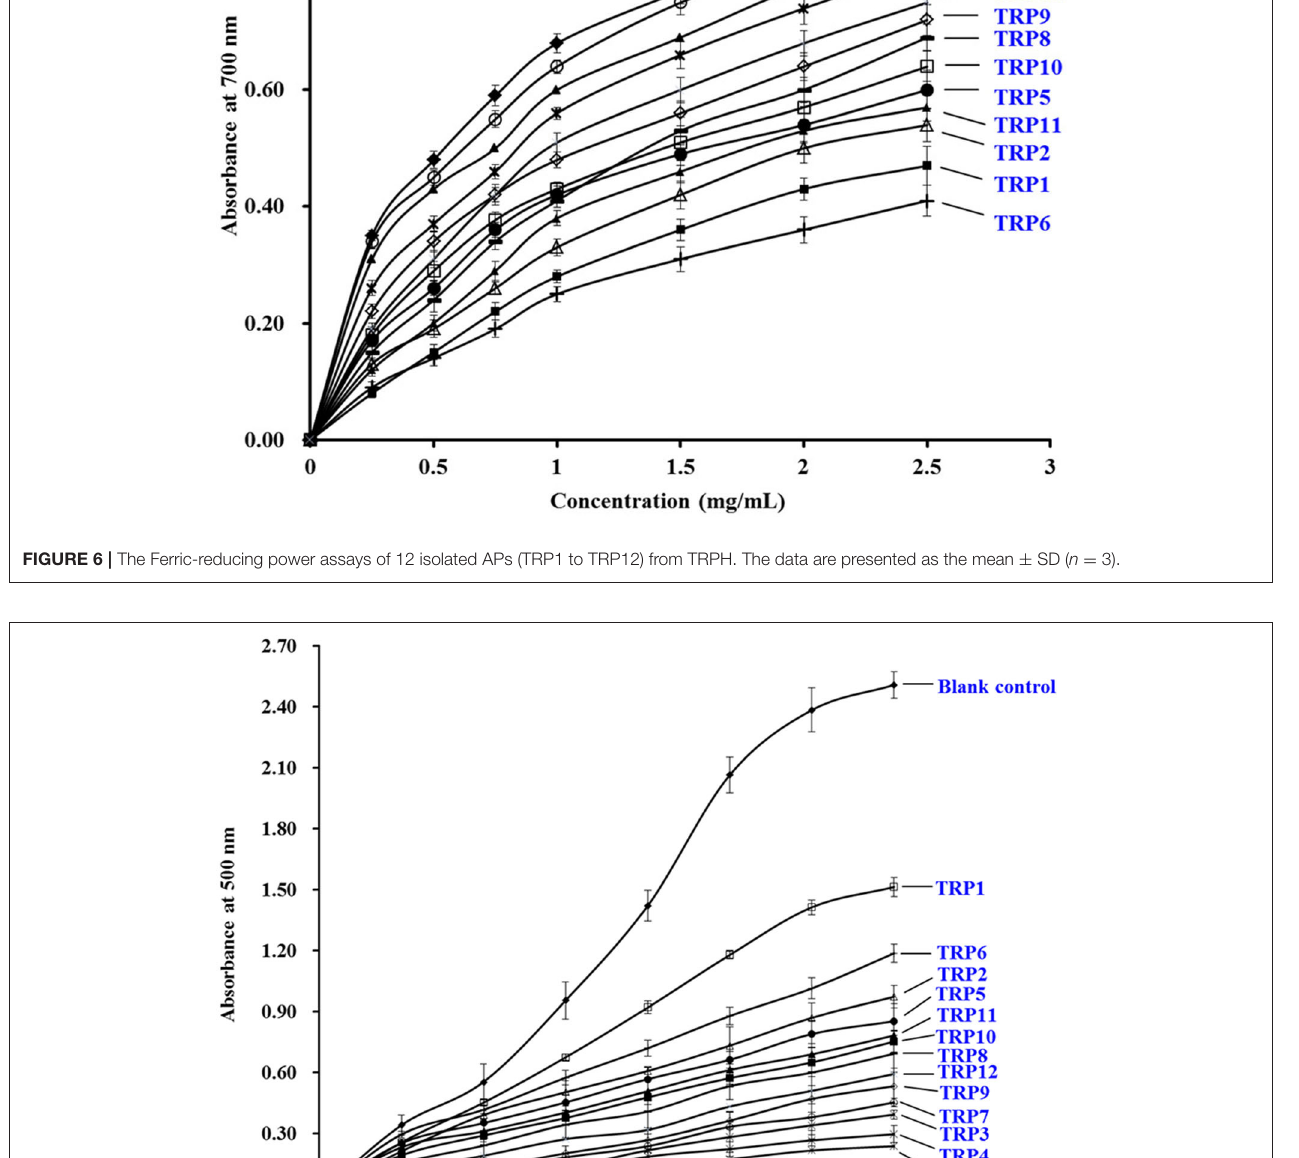
that TRP6 could promote the proliferation of Chang live cells. In addition, the cell viability of other 10 peptides groups ranged from 95.93 ± 2.48% (TRP8) to 104.91 ± 2.56% (TRP1), and